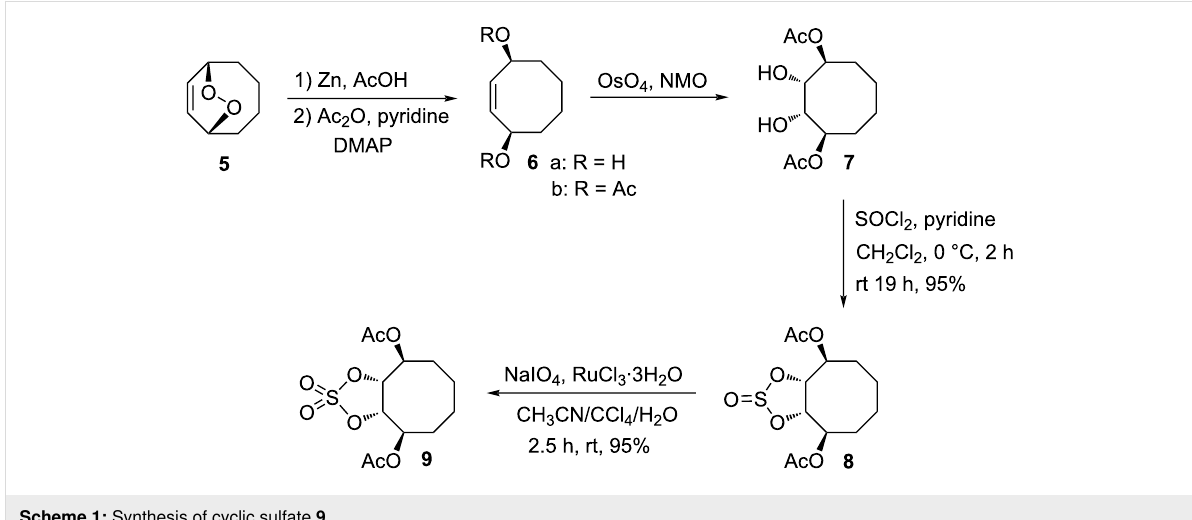
rivatives are used as both inhibitors of glycosidases and useful intermediates in organic synthesis [18]. Halocyclitols are also cyclitol derivatives, in which one of the hydroxy groups is replaced by a halogen. They have also attracted interest in the last decade because of their biological activities [11,19]. For instance, some brominated quercitol (cyclohexanepentol) deriv- atives and bromoconduritol-B act as strong inhibitors of α -glycosidases [11,19]. Recent reviews report on the latest syn- thetic methodologies for aminocyclitols and related compounds